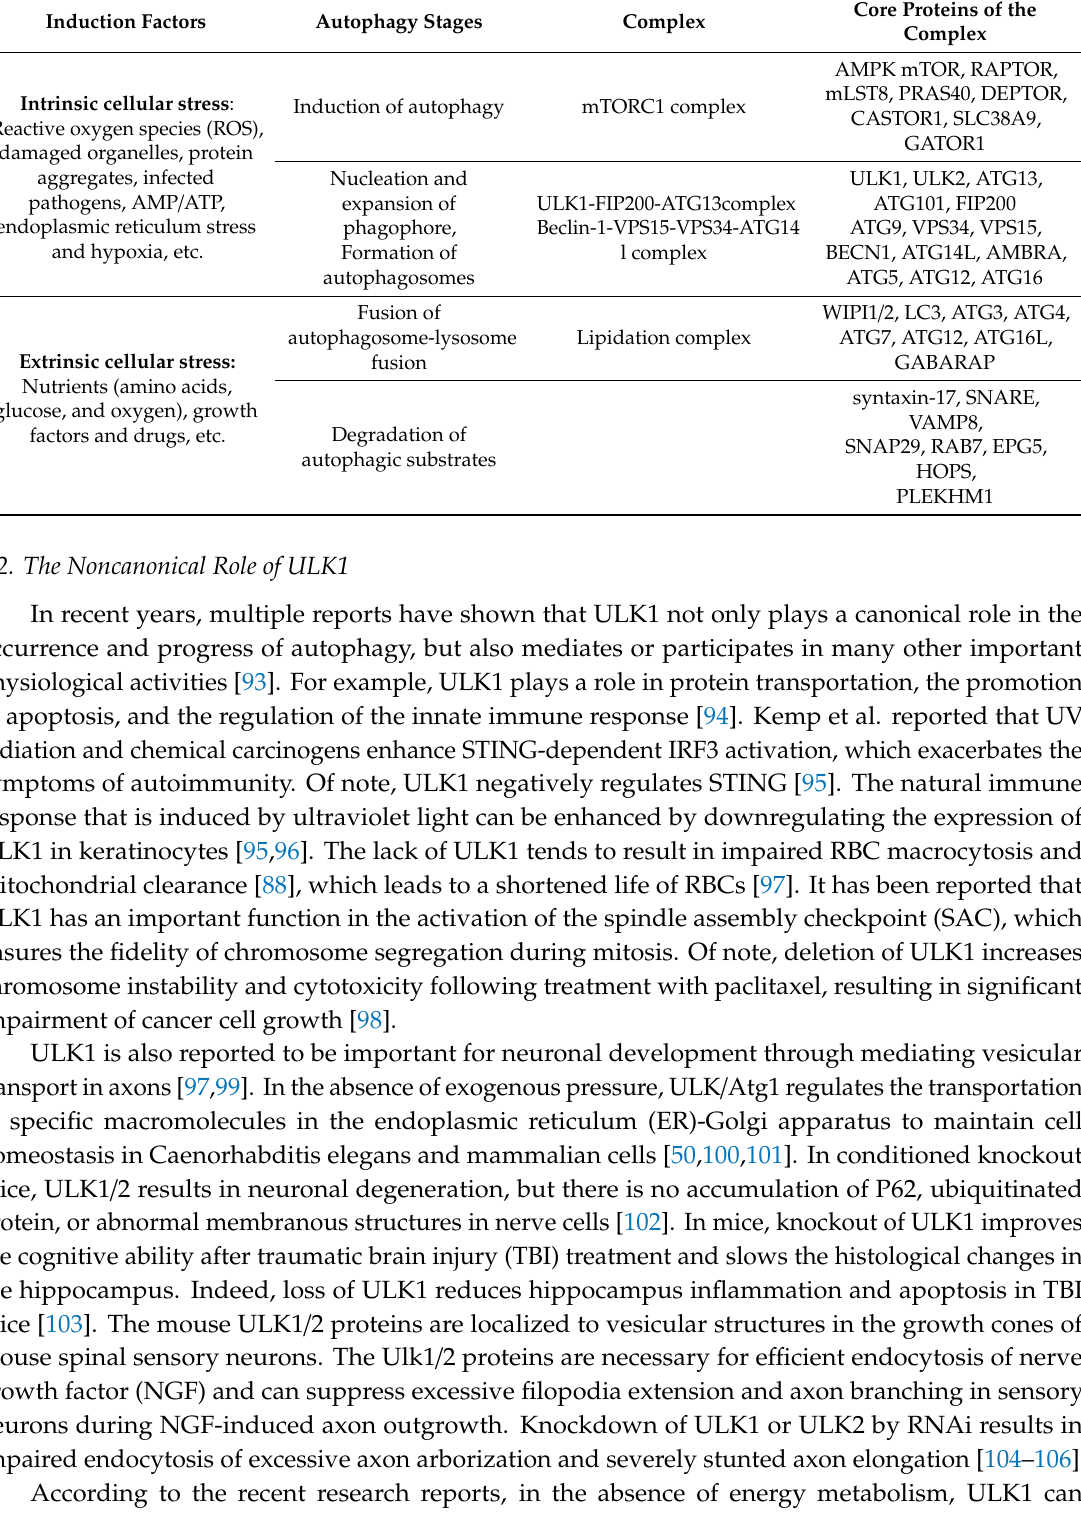
Intrinsic cellular stress : Reactive oxygen species (ROS), damaged organelles, protein aggregates, infected pathogens, AMP / ATP, endoplasmic reticulum stress and hypoxia,